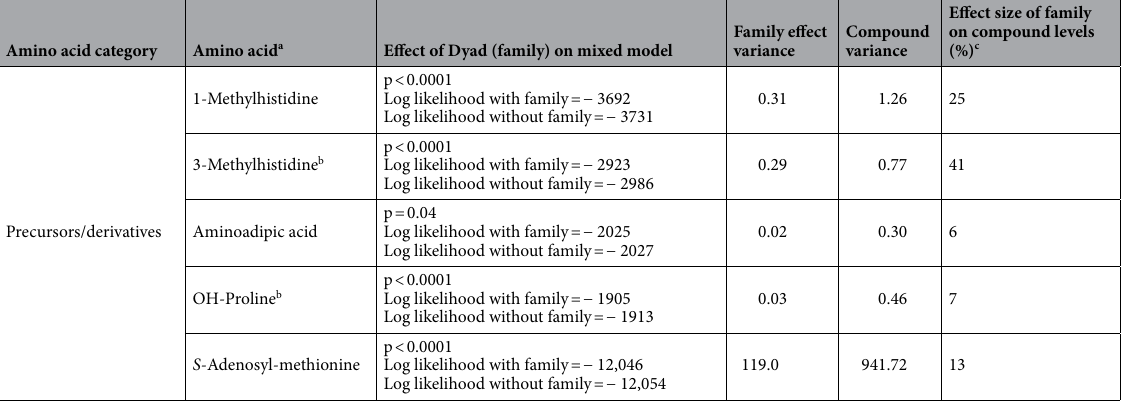
Table 2. Family effects, variances and effect sizes on amino acid levels. a All in µM except for S -Adenosylmethionine in nM. b Log transformed variables with back-transformed means and standard deviations. c Calculated as the family (dyad) effect variance divided by the plate-adjusted compound variance ×